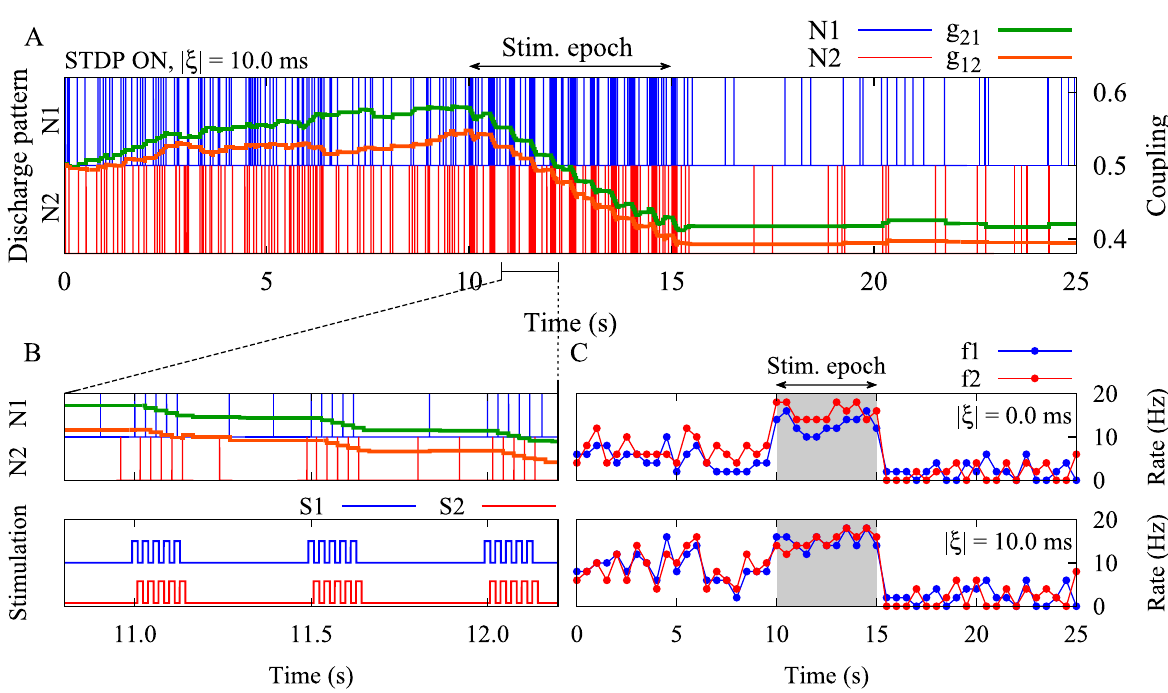
Fig 3. Suppression of the synaptic strengths between two neurons by time-shifted stimulation. ( A ) Time course of neuron discharges (N1/N2) and the synaptic strengths ( g 21 / g 12 ) are shown for two neurons when STDP parameters were A + = 0.008, A and | ξ | = 10.0 ms. ( B ) (Top) Results in panel A are shown with a higher resolution. (Bottom) Stimulation signals were delivered to N1 (S1) and N2 (S2) for the duration of T stim = 5 s (stimulation ON period in A) with time shift Δ t = 5 ms and frequency ν = 33.3 Hz (inspired by parameters shown in point b in Fig 2C). ( C ) Time course of the mean firing rate of neurons ( f 1/ f 2) for | ξ | = 0.0 ms (top) with ( Δ t , T ) = (15, 30) ms and for | ξ | = 10.0 ms (bottom) with ( Δ t , T ) = (5, 30)